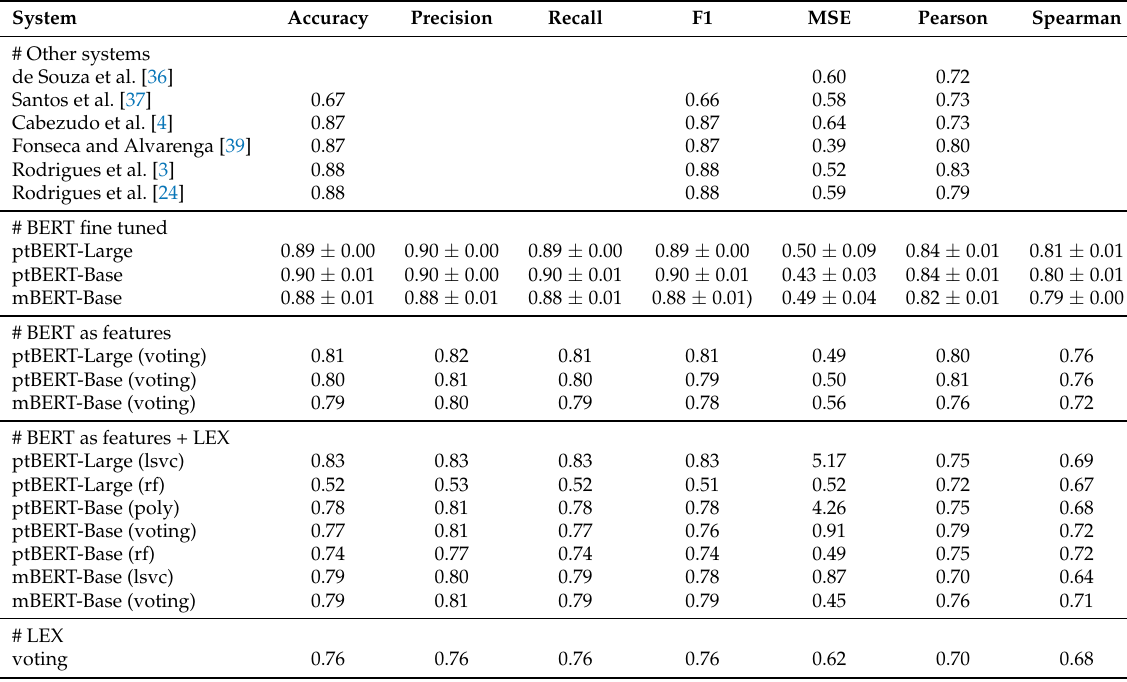
Table 7. ASSIN2 NLI and STS results.